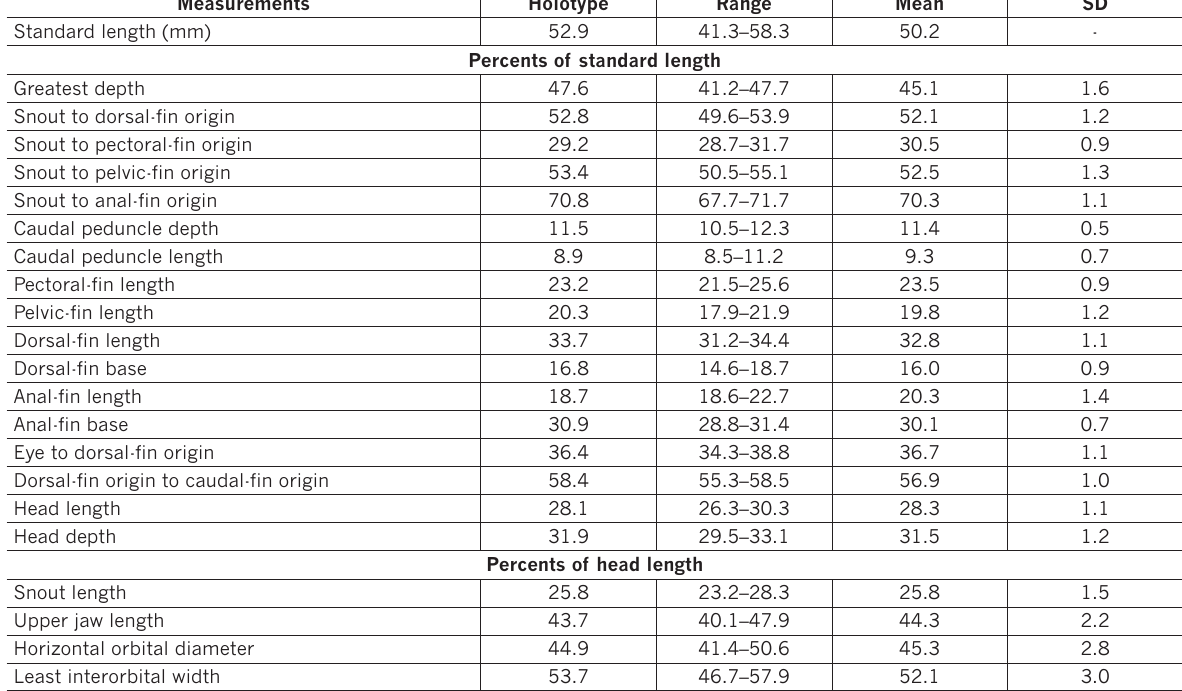
Table 1. Morphometric data of holotype and paratypes of Moenkhausia britskii from Içá River, Amazon basin (n = 17). Range includes the holotype.